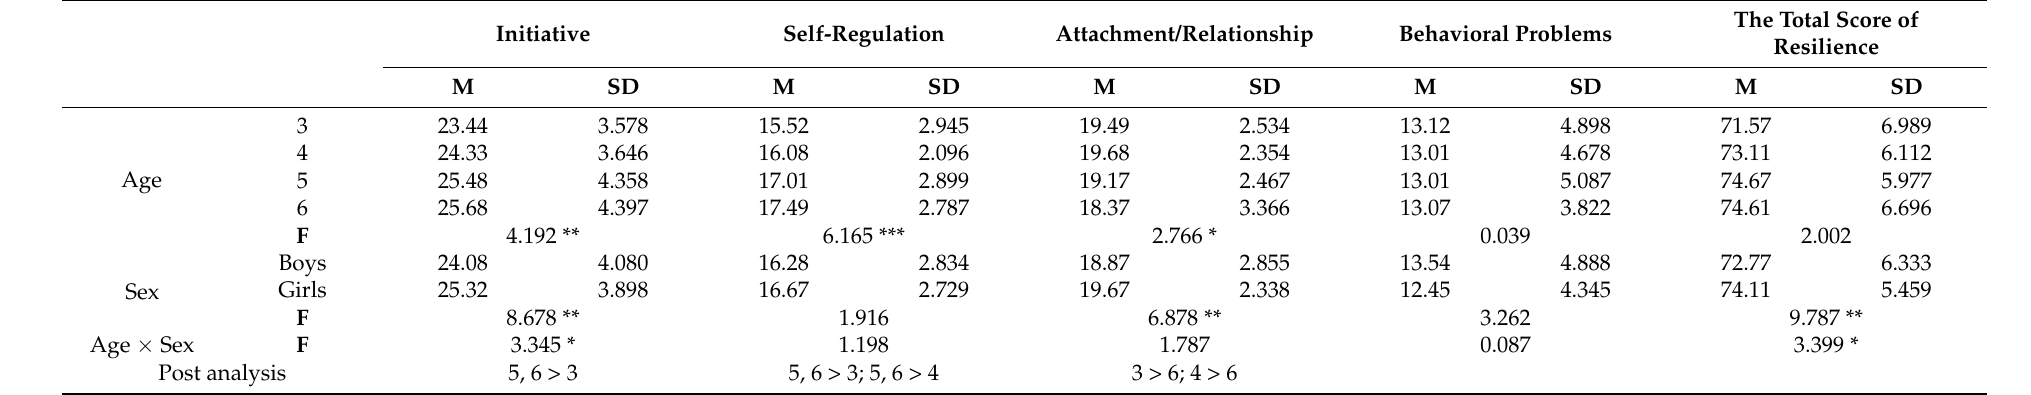
Table 5. General information and difference analysis of